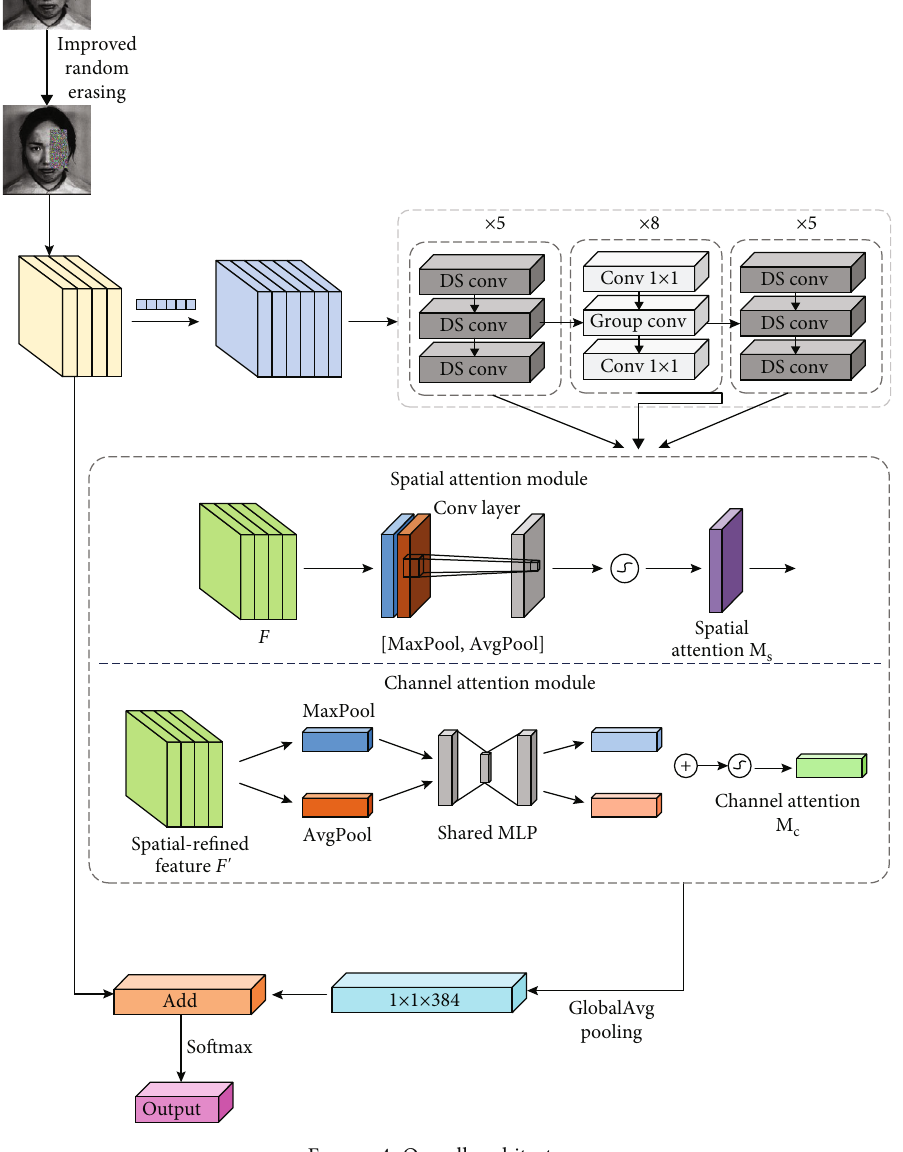
Figure 4: Overall